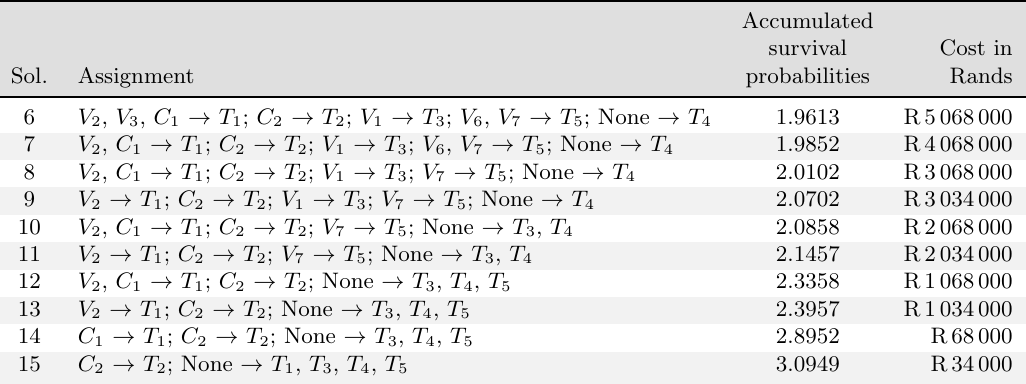
Table 7: The set of approximately Pareto optimal solutions obtained by the NSGA II for stage t 39 of the scenario, using the same solution indices as in Figure